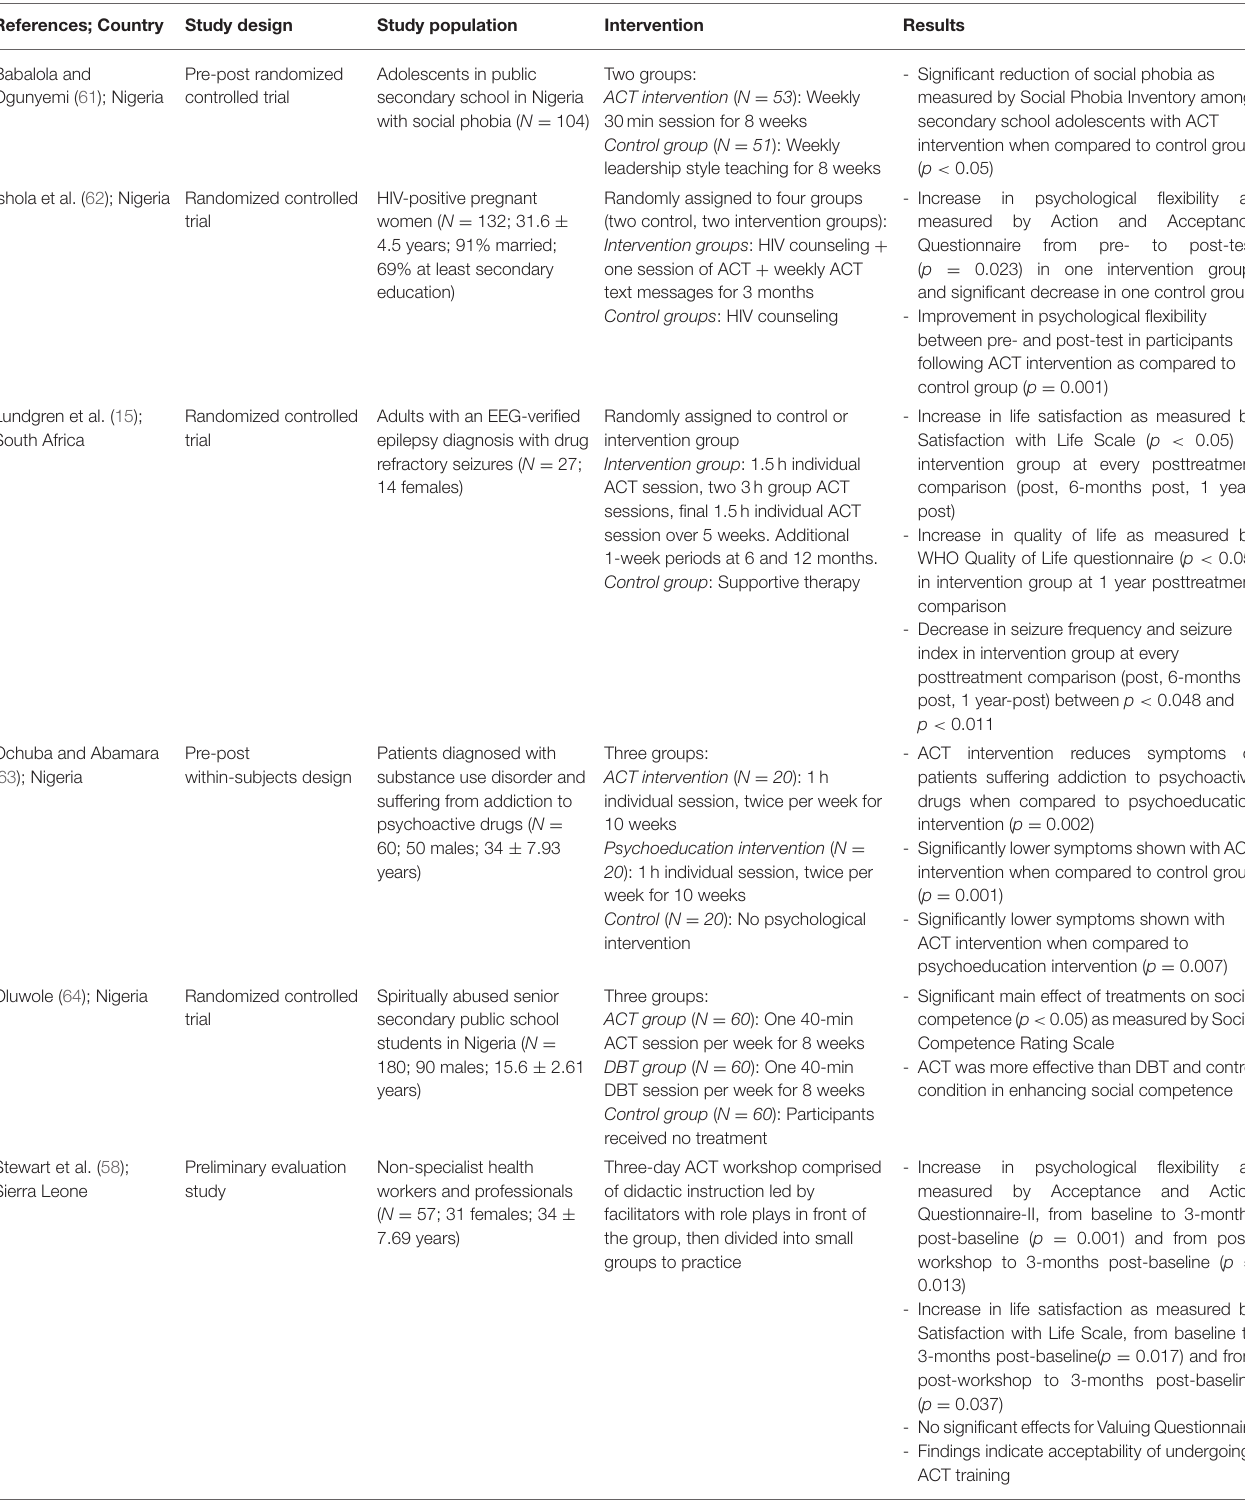
TABLE 1 | Overview of ACT-based intervention studies in Africa. References; Country Study